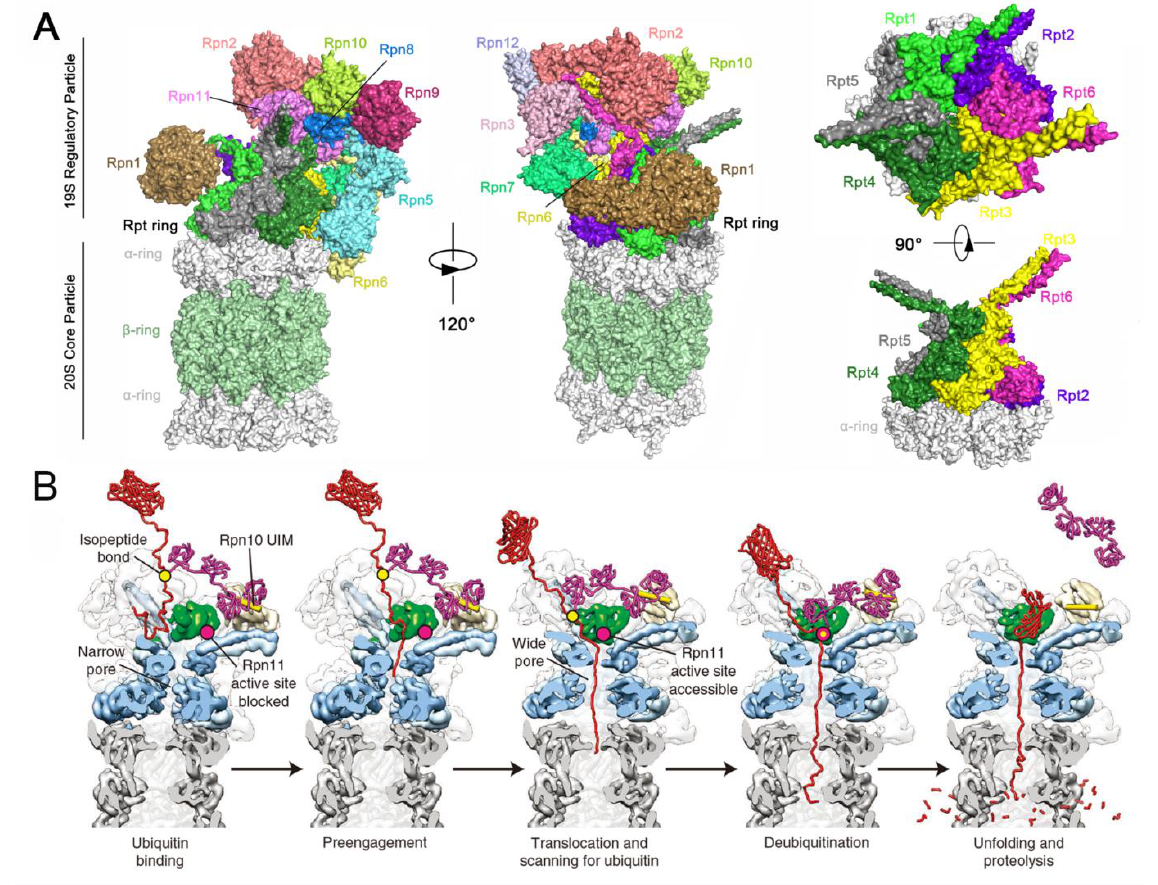
Figure 6. ( A ) High-resolution structure of human 26S proteasome. Figures were generated from PDB 5VFS. The α rings are in gray and the β ring is in pale green. The Rpn1-Rpn3 and Rpn5-Rpn12 are colored brown, orange, pink, cyan, yellow, green, blue, orange red, limon, magenta, and light blue, respectively. The Rpt1-Rpt6 are colored light green, purple, light yellow, dark green, dark gray, and violet, respectively. ( B ) Structure-based model for substrate engagement and degradation by the 26S proteasome. The substrate, ubiquitin chain, Rpn10 UIM, Rpn11, and N-ring with subja- cent peptidase are colored red, purple, yellow cylinder, green, and gray, respectively. Panels B are adapted with permission from [136]. Copyright 2013 Springer Nature.